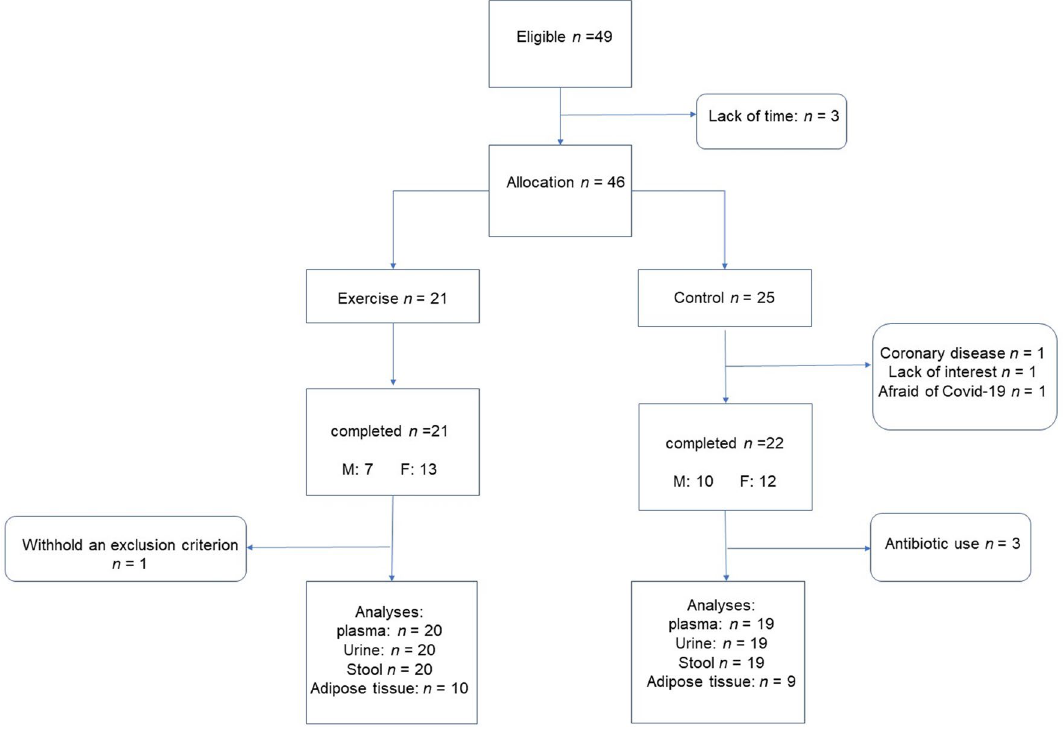
Figure 1. Flow chart of the study, M male, F